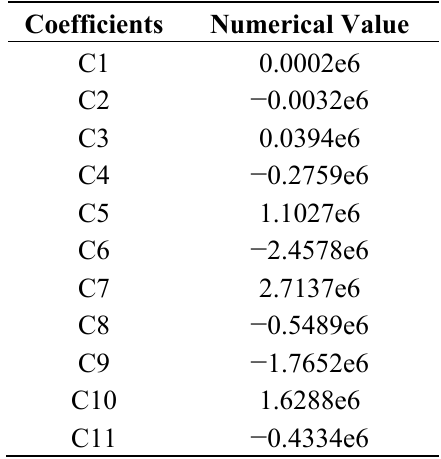
Table 2. Calculated coefficients from the spectral approximation method.